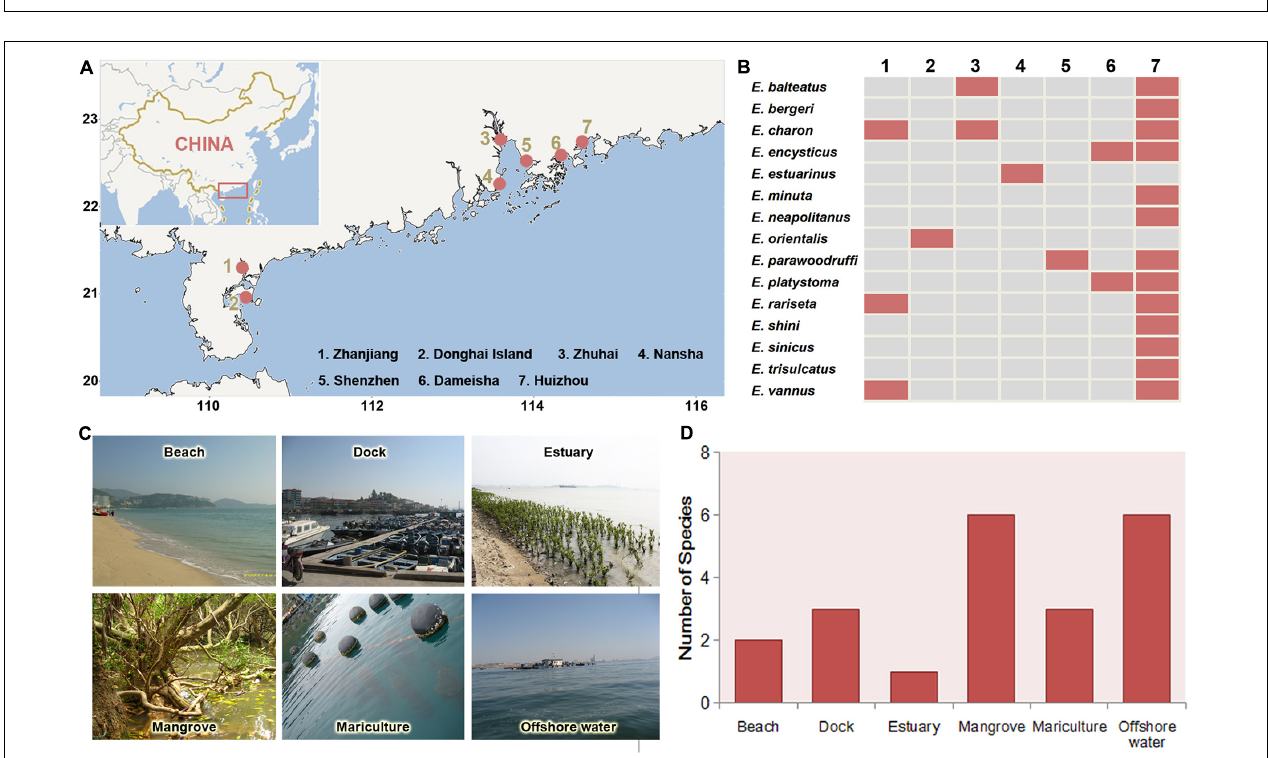
FIGURE 7 | Geographic distribution of the Euplotes species in coastal waters of southern China. (A) Locations (red spots) where the species were collected. (B) Distributions of each species in the seven sites. (C) Main habitat types. (D) Species richness in each habitat